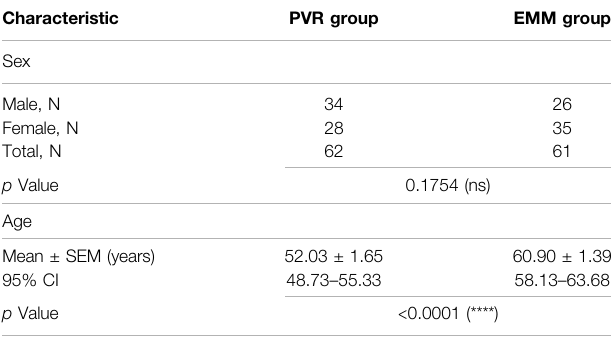
TABLE 1 | Basic characteristics of the study